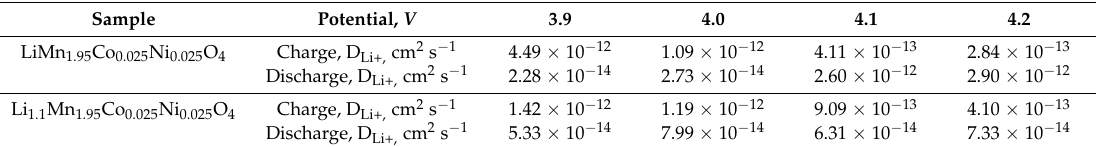
Table 3. Li + apparent diffusion coefficients at different charge and discharge potentials in